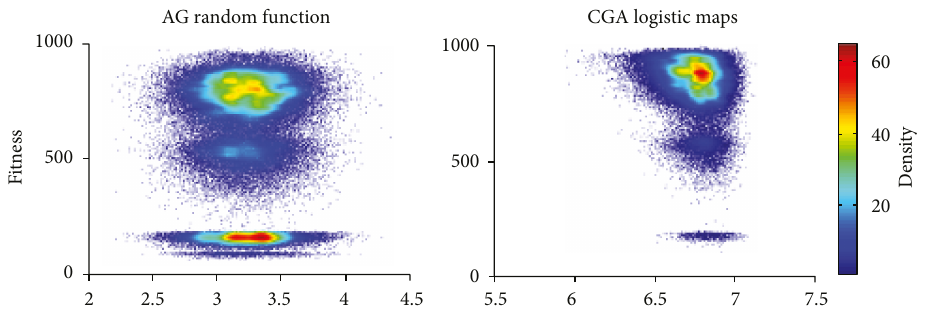
Figure 12: Performance of the CGA with respect to